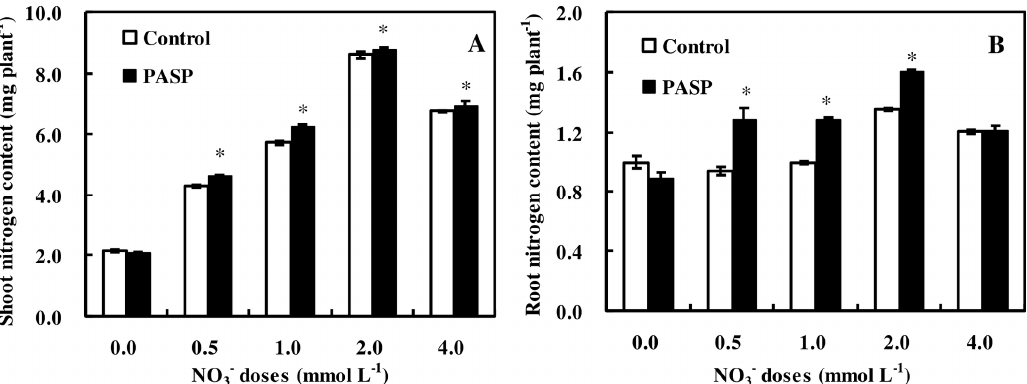
Figure 2. Total nitrogen accumulations in the shoots ( A ) and roots ( B ) of maize on the 7th day after nitrogen and PASP treatment. The PASP and control indicate seedlings with and without PASP addition, respectively. Data rewash presented as the mean ± standard error of 15 plants in each treatment. *, Statistically significant differences between PASP treatment and control within each nitrogen level, according to Student’s test at p < 0.05.